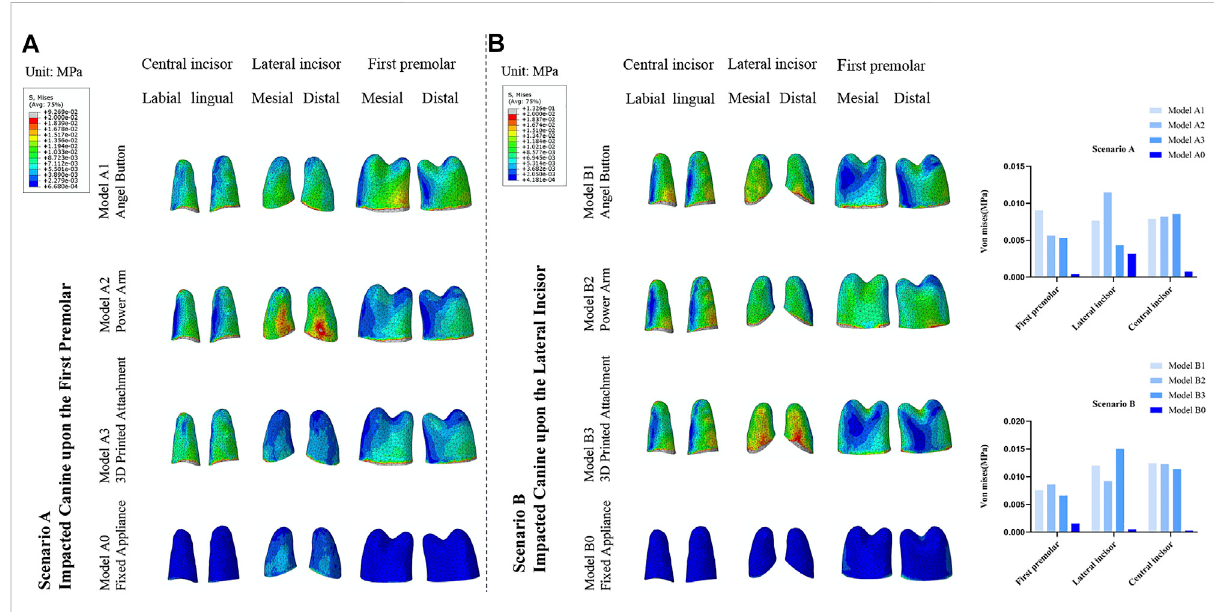
FIGURE 8 (A) Distribution of von Mises stresses in the PDL of the adjacent central incisor, lateral incisor, and fi rst premolar in the traction models of Scenario A and Scenario B. (B) Stress value for average von Mises in the PDL of the adjacent central incisor, lateral incisor, and fi rst